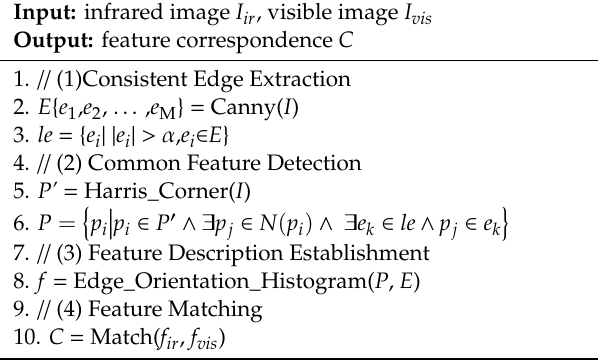
Table 1. Algorithm